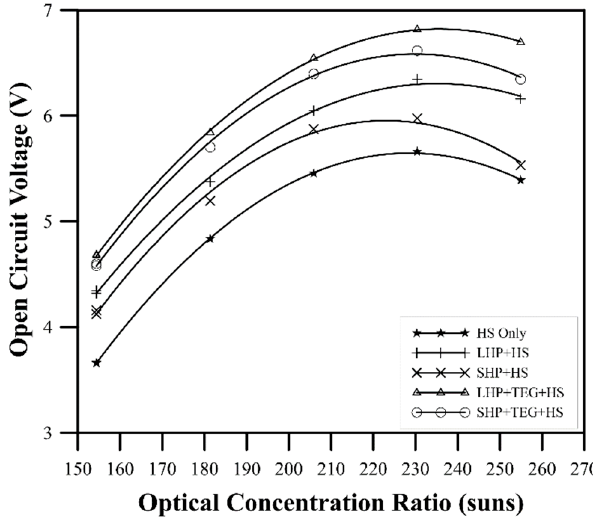
Figure 11. Total generated power as a function of the optical concentration ratio.